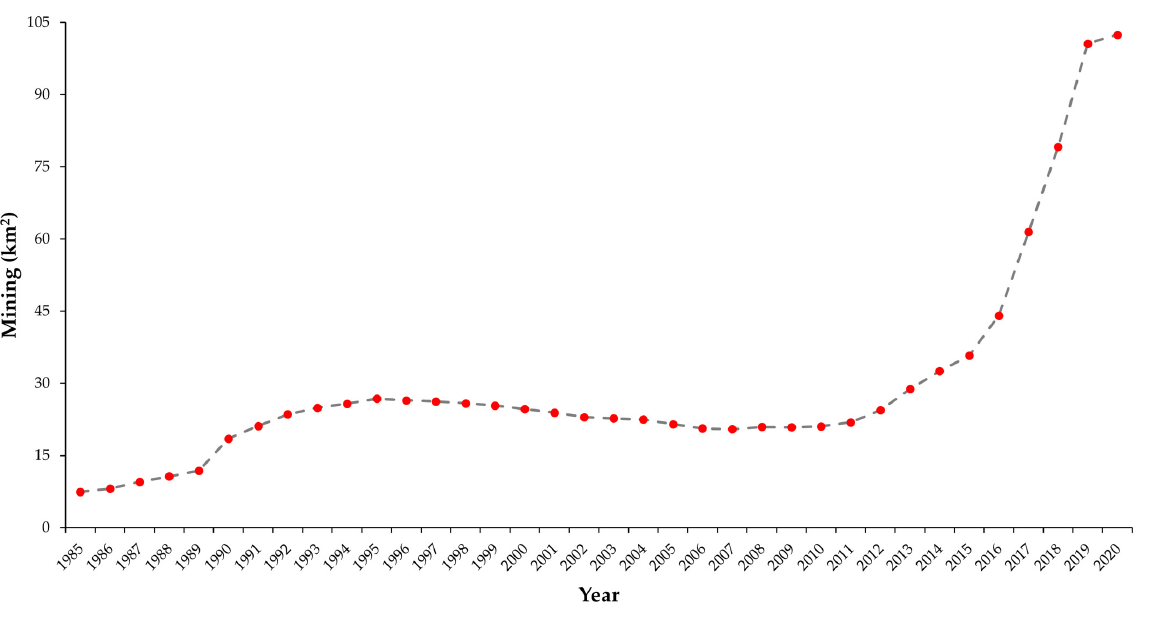
Figure 2. Total area (km 2 ) classified as mining by the MapBiomas LULC dataset collection 6 from 1985 to 2020 within Indigenous Lands of the Brazilian Legal Amazon.